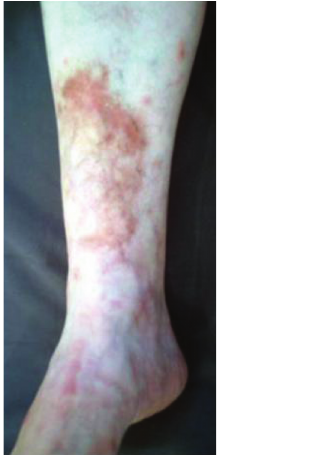
Figure 2: By the fourth infliximab infusion, the ulcers healed completely and allowed steroids